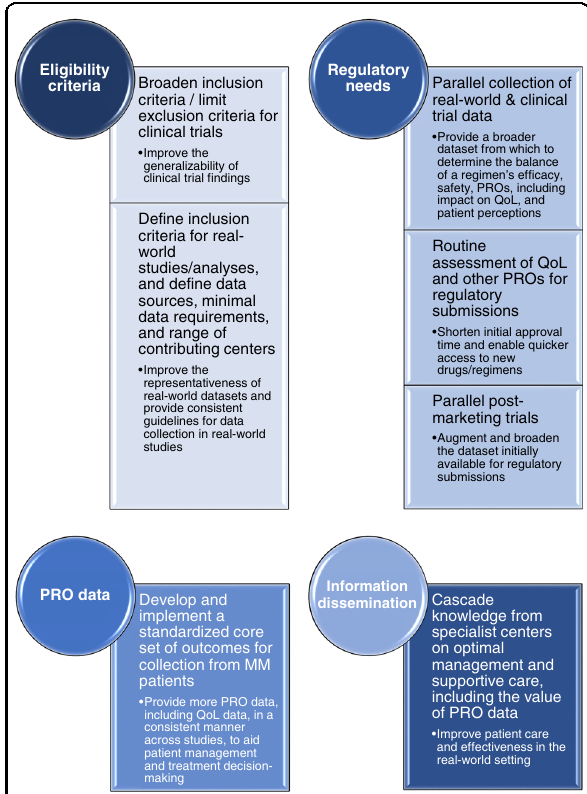
Fig. 2 Enhancing MM data collection. Recommendations for enhancing future data collection on MM treatment regimens. MM, multiple myeloma; PRO, patient-reported outcome; QoL, quality of